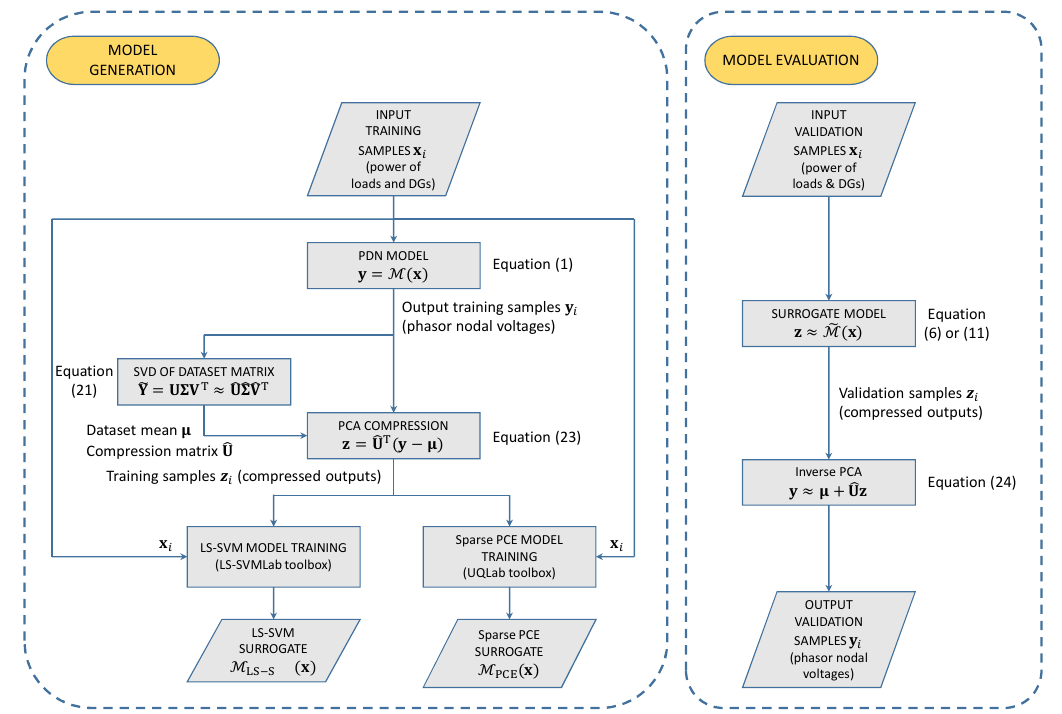
Figure 4. Flowchart of the proposed modeling